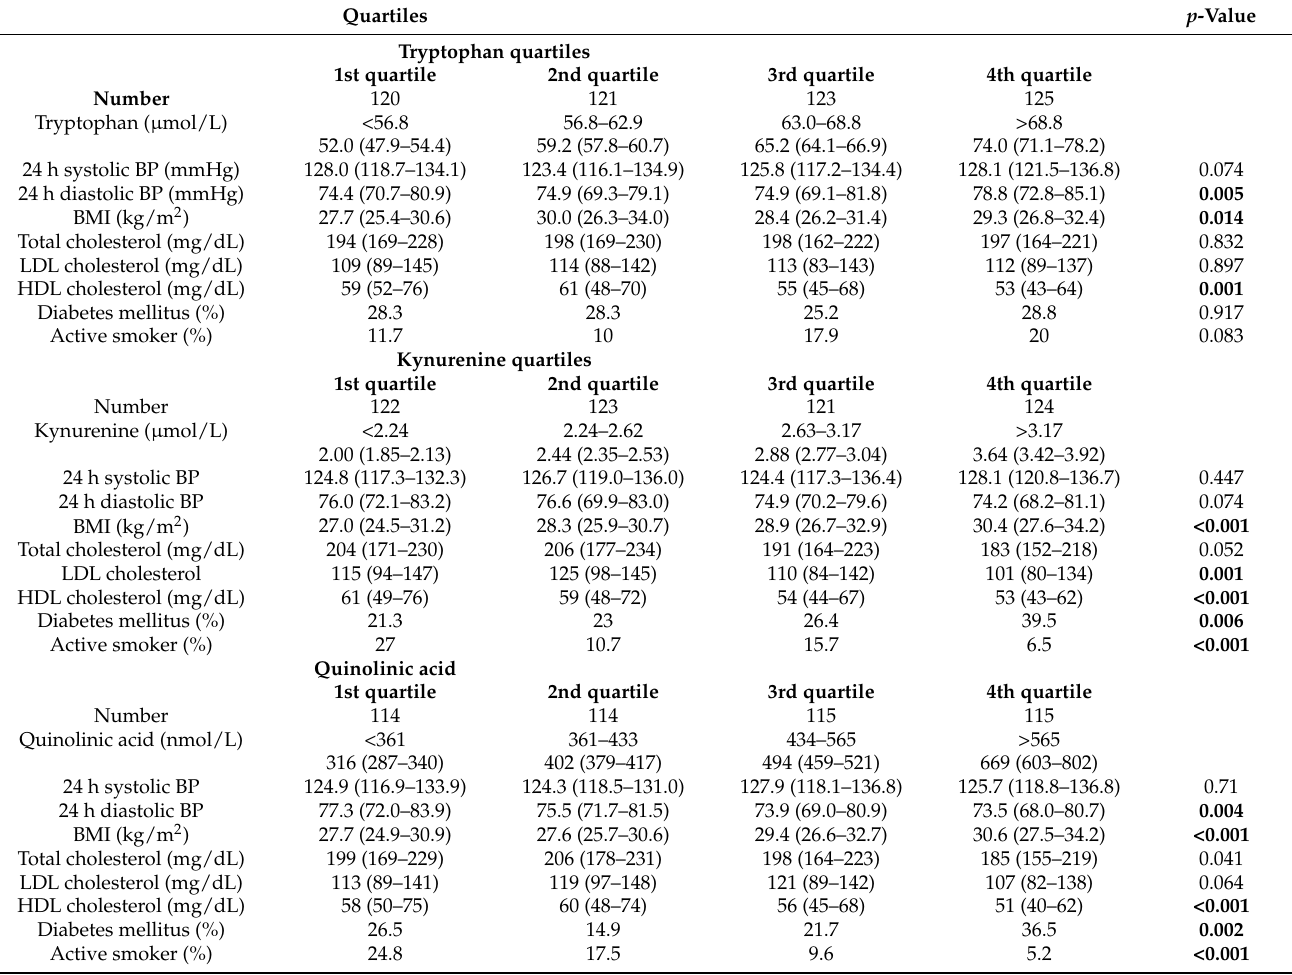
Table 4. Associations of tryptophan, kynurenine, quinolinic acid, kynurenic acid and kynure- nine/tryptophan ratio with cardiovascular risk